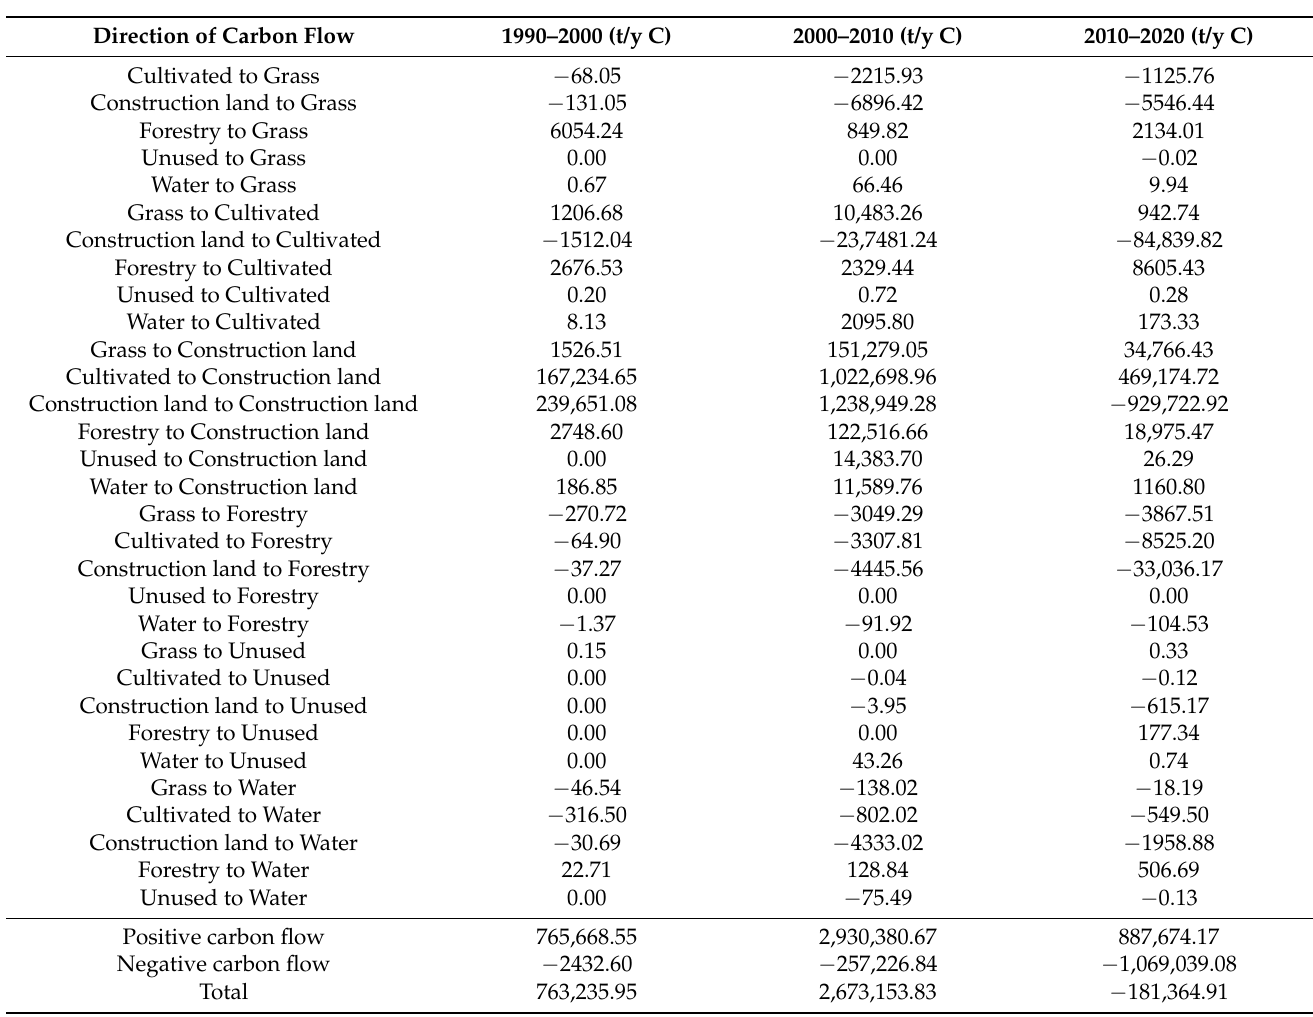
Table 4. Carbon flow from 1990 to